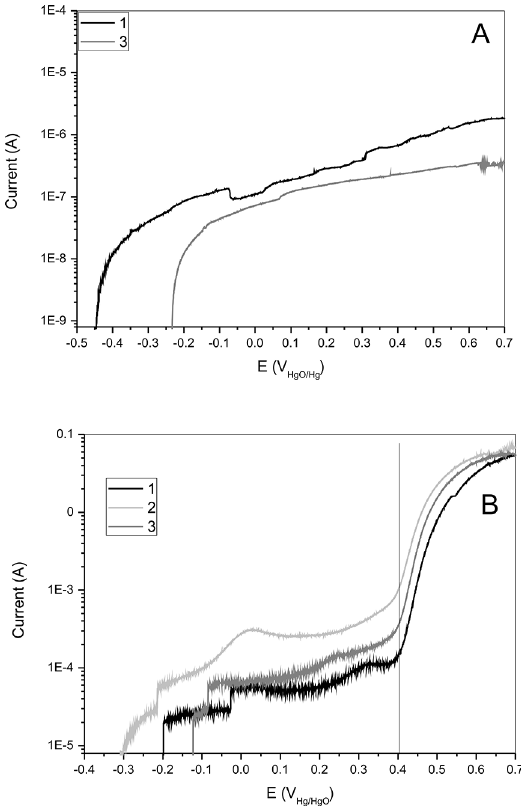
Figure 4. Polarization curves of the coatings produced using Solution 1 (A) and Solution 2 (B) under the conditions described